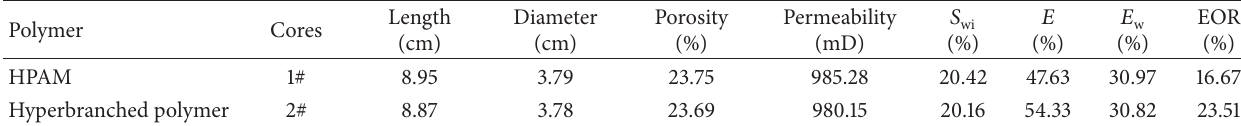
Table 2: The parameters of cores and the results of core flooding tests.